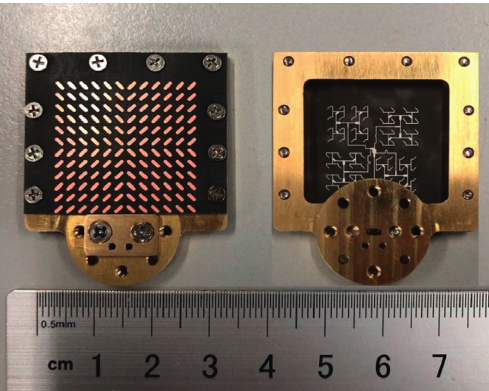
Figure 14: Prototype of antenna array with RCS reduction.